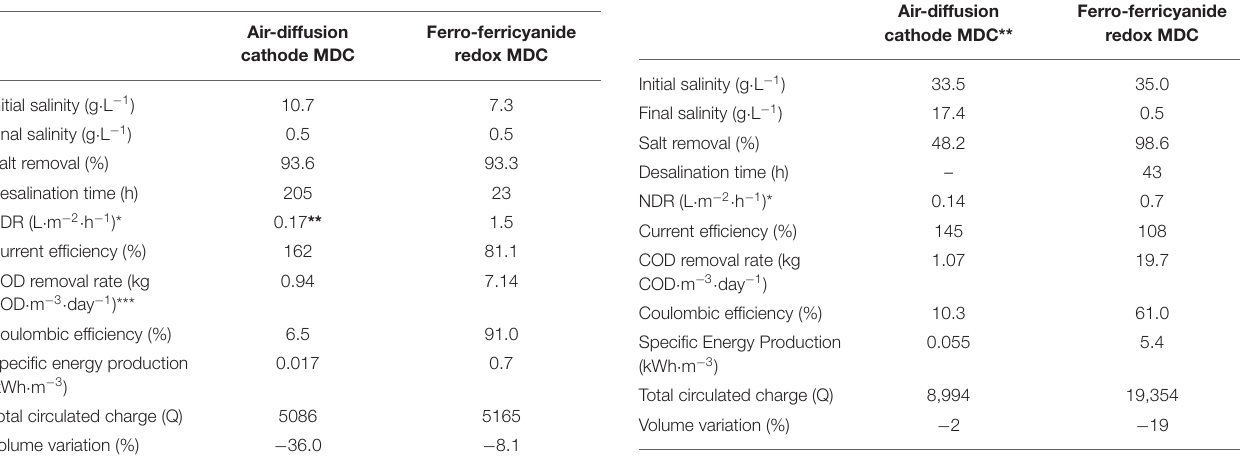
TABLE 2 | Initial and final salinity, salt removal, desalination time, current efficiency, nominal desalination rate, COD removal rate, anode coulombic efficiency, specific energy production, total circulated charge and volume variation for air diffusion cathode and ferro-ferricyanide redox MDC experiments for brackish water desalination.